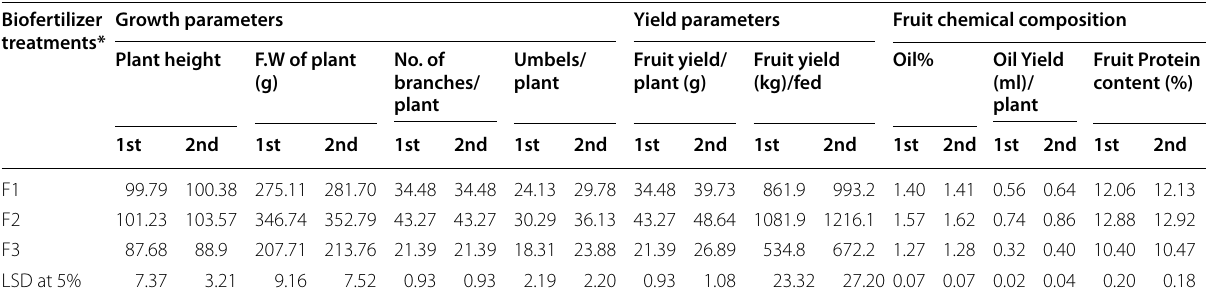
Table 2 Fennel growth, yield parameters and fruit chemical composition affected by the biofertilizers during 2017/2018